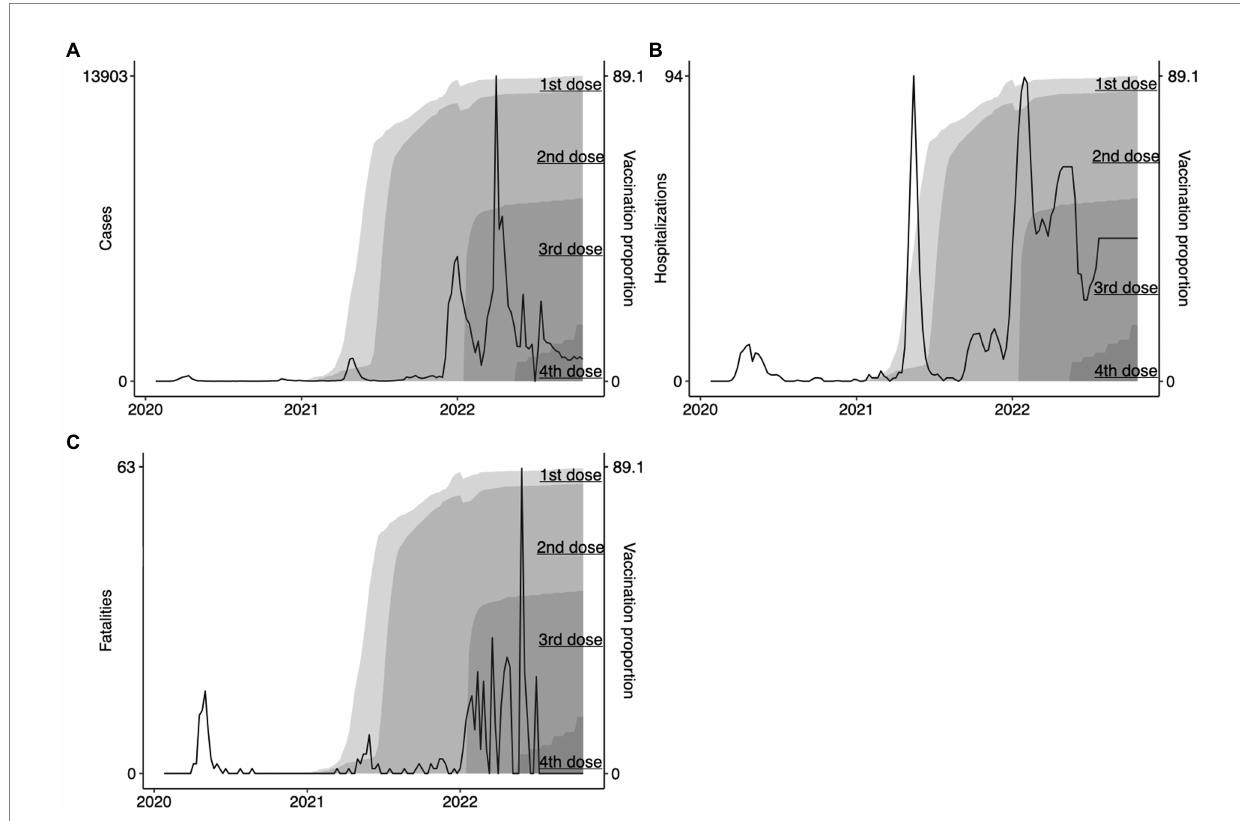
FIGURE 5 Evolution of COVID-19 vaccination in Nova Scotia. We show the evolution of vaccination rates in Nova Scotia represented in the proportion of the population that had took their 1st dose, 2nd dose, 1st booster, and 2nd booster (labeled gray areas in the right-hand side of panels A – cases, B – hospitalizations, and C –